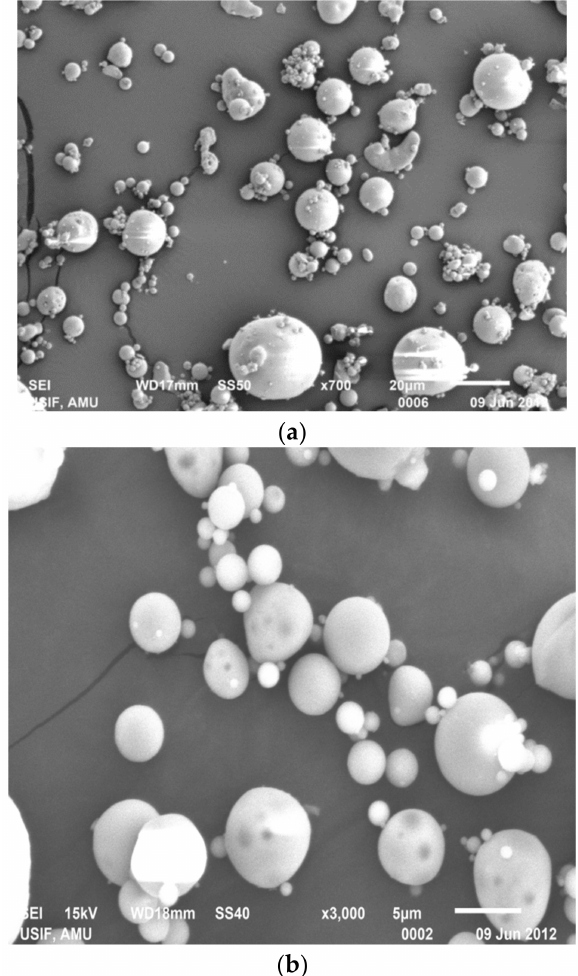
Figure 1. Scanning electron micrographs of fly ash with different magnification factors: ( a ) 700; ( b ) 3000.